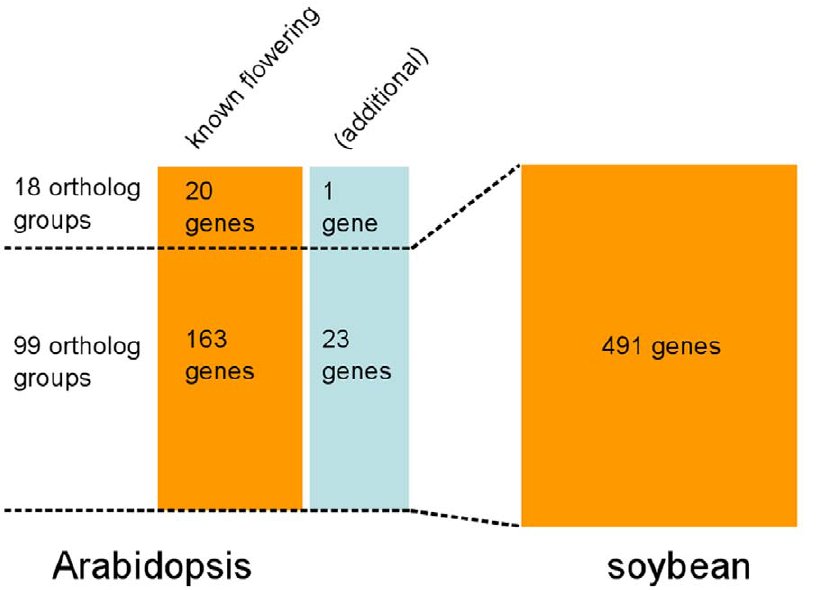
Figure 1. Number of orthologue groups and genes related to flowering pathways. 183 Arabidopsis flowering genes are classified into 117 orthologue groups along with 24 additional genes. Function of these additional genes has not been investigated so far. Out of the 117 OGs, 99 OGs contain 491 soybean genes that are putative soybean flowering genes. The numbers of genes are indicated within each box.